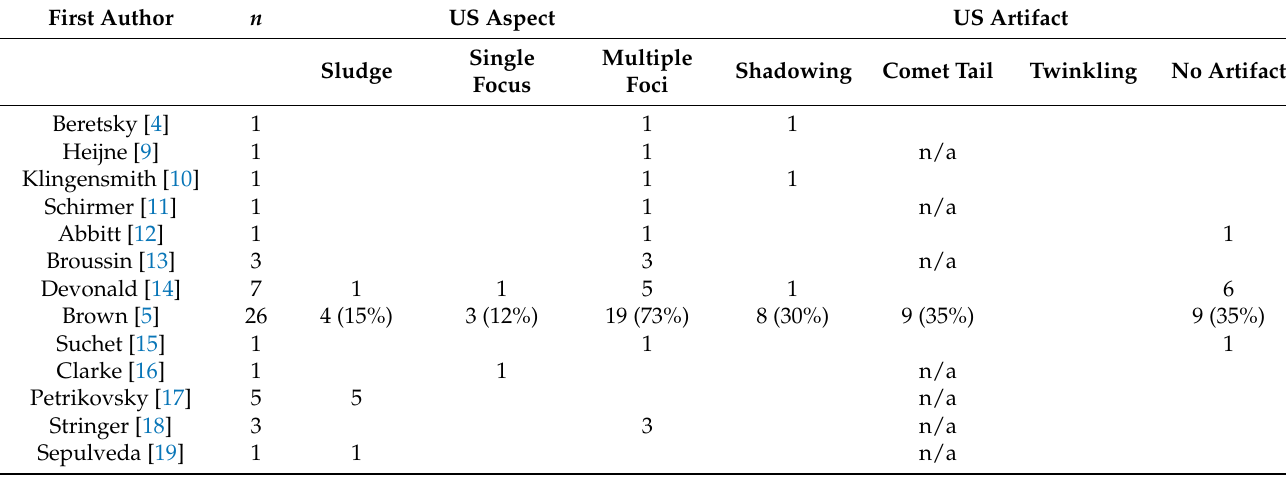
Table 2. Ultrasound features of the echogenic content detected in the fetal